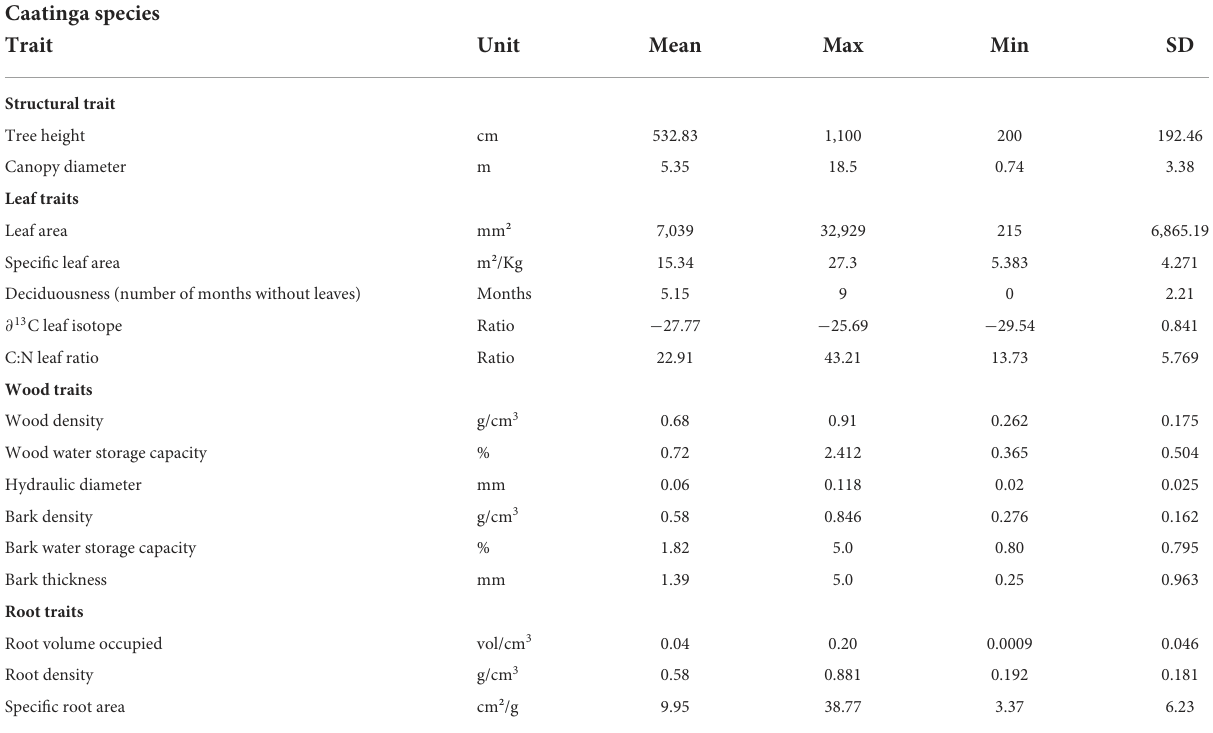
TABLE 2 Functional traits